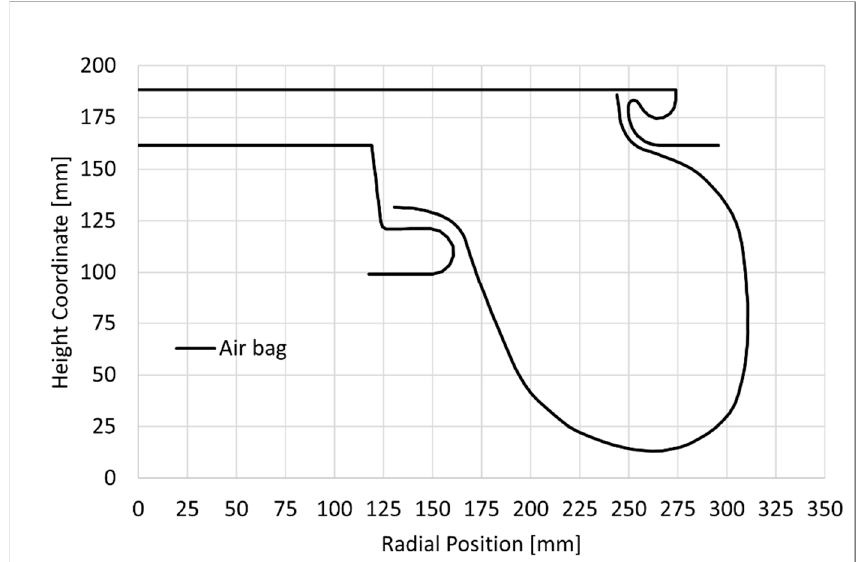
Figure 4. Air bag model for angle calculation and analysis.